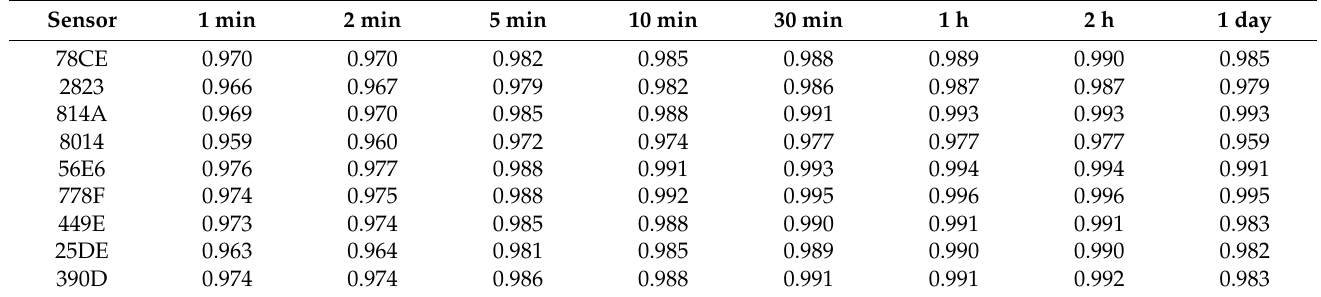
Table 4. Relationship between the average period and the agreement between the reference and other sensors. Assessment based on r 2 . Benchmark test conducted in August 2021.